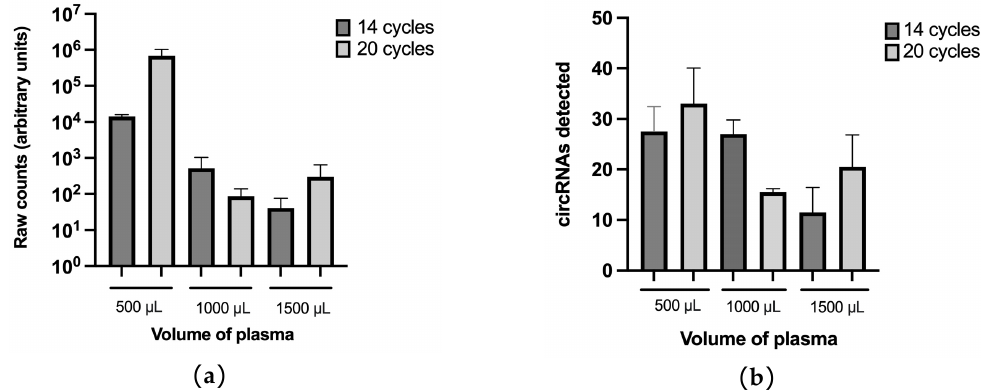
Figure 2. Plasma input testing. ( a ) Total number of counts and ( b ) number of circRNAs detected by nCounter with each of the volumes of plasma tested with 14 and 20 cycles of pre-amplification. Plasma from a NSCLC patient was used for this purpose. Error bars indicate standard deviation.